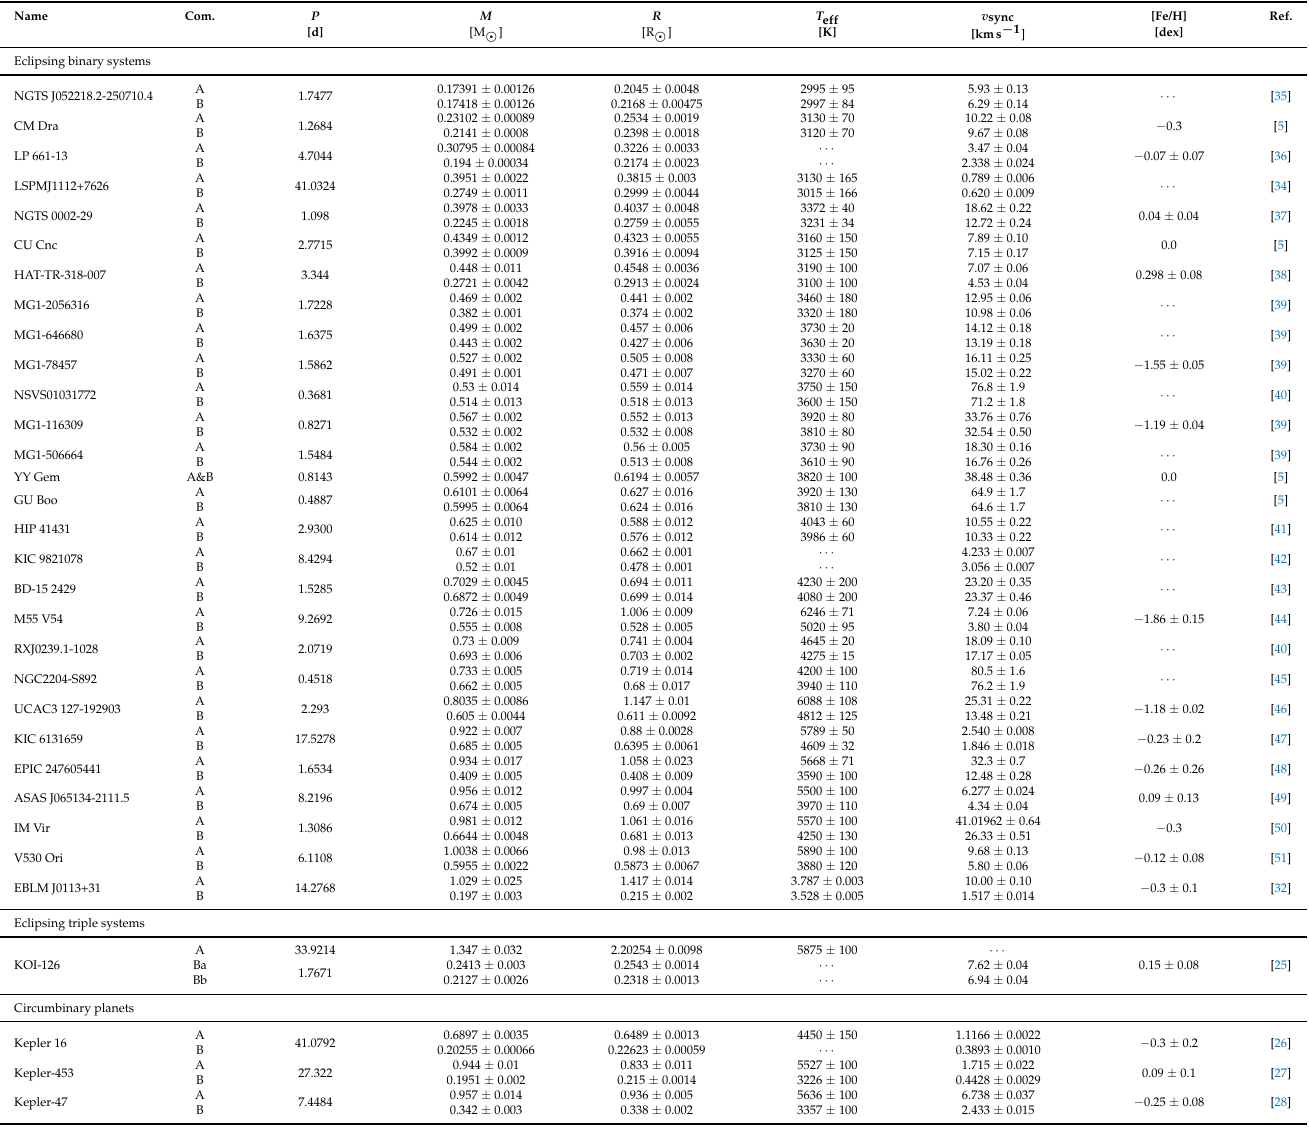
Table 1. List of DLEBs and multiple systems with a least one stellar component with a mass (cid:46) 0.7M (cid:12) and mass and radius uncertainties below